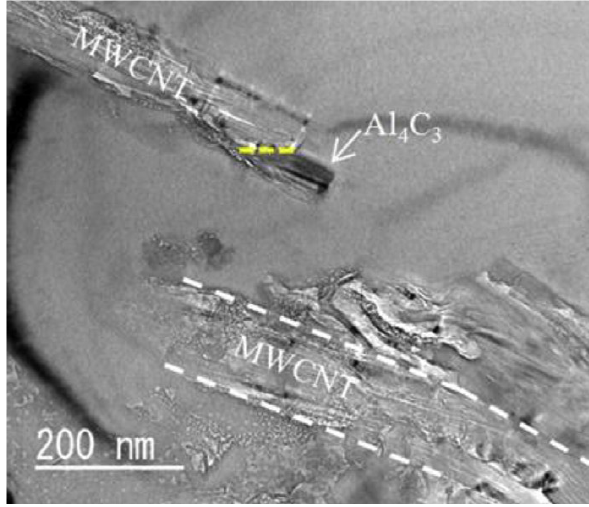
Figure 5: TEM images of Al 4 C 3 formation at the end of MWCNT